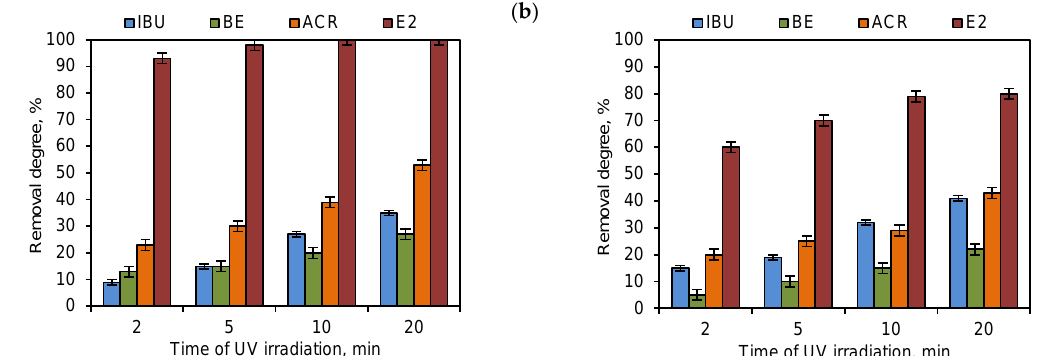
Figure 3. Change of CECs concentration during the UV/NaOCl/H 2 O 2 conducted on ( a ) deionized and ( b ) surface water solutions.